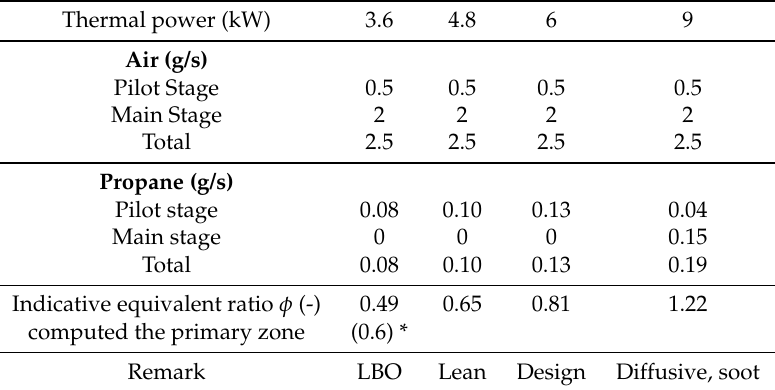
Table 3. Burner operating conditions for the atmospheric tests.